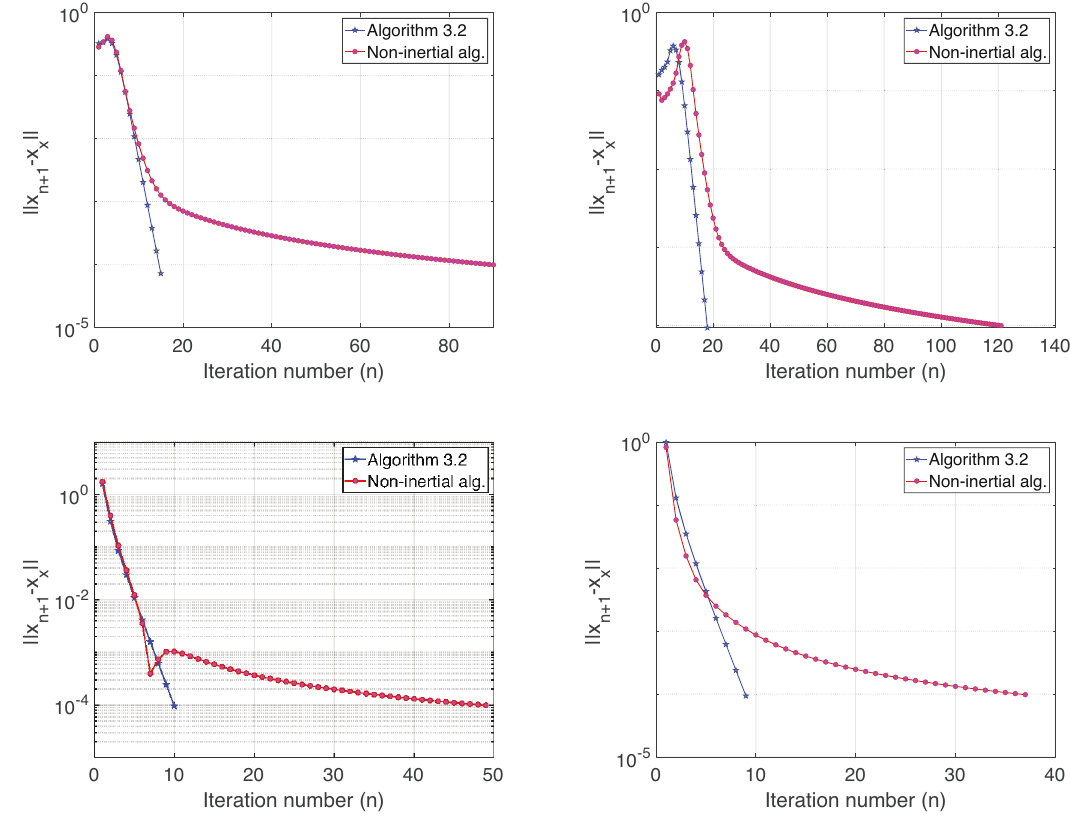
Figure 1: Example 4.1, Top Left: Case I ; Top Right: Case II ; Bottom Left: Case III ; Bottom Right: Case IV